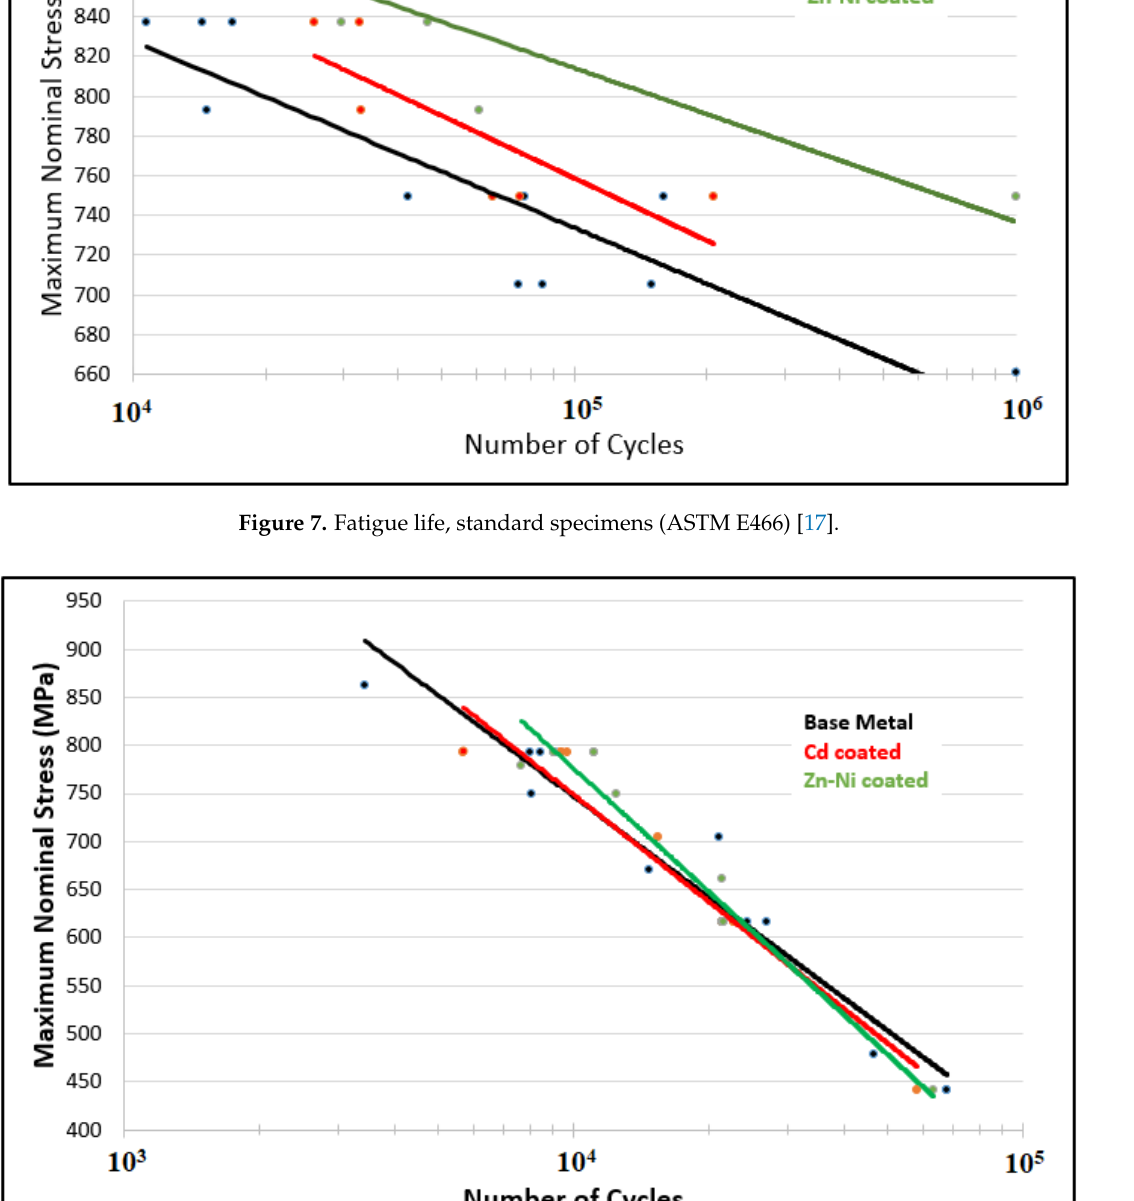
Figure 7. Fatigue life, standard specimens (ASTM E466) [17].